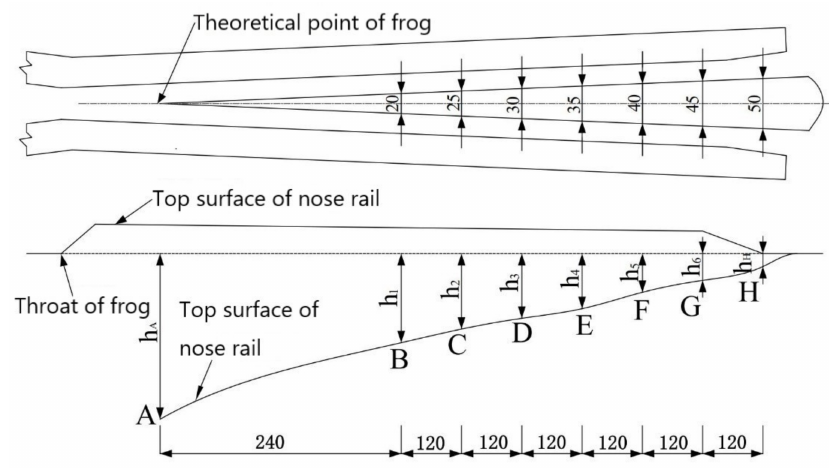
Figure 13. Plan and side view of the nose rail.